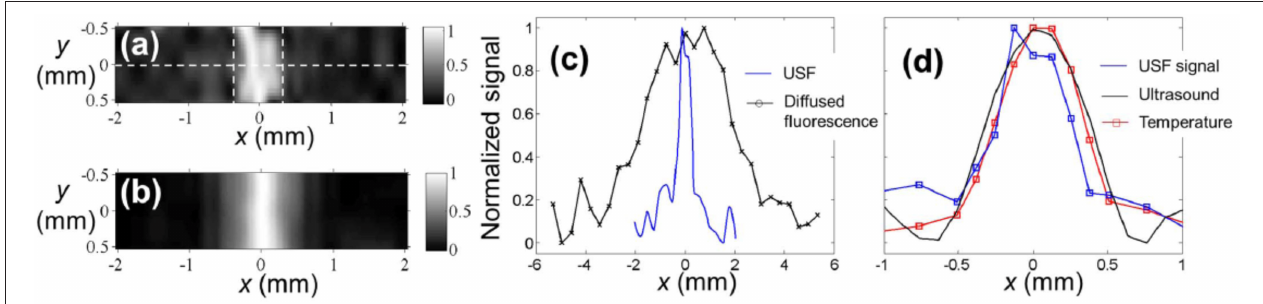
FIGURE 7 | The USF image of the tube embedded into the porcine muscle tissue (Pei et al., 2014). ICG-encapsulated PNIPAM NPs were used as the contrast agents. The two dashed vertical lines represent the inner boundaries between the tube and USF contrast agents. (b) The diffraction-limited ultrasound image (C-mode) of the same tube in the tissue, obtained by raster scanning the same HIFU transducer on the x-y plane. (c) The profiles of the USF signal and the diffused fluorescence signal along the x axis at y = 0 (see the dashed horizontal line in (a) . (d) The profiles of the USF, ultrasound, and temperature signals along the x axis at y = 0. Both the USF and ultrasound image were normalized and interpolated based on a bicubic method. Reproduced with permission. Copyright 2014 © Springer